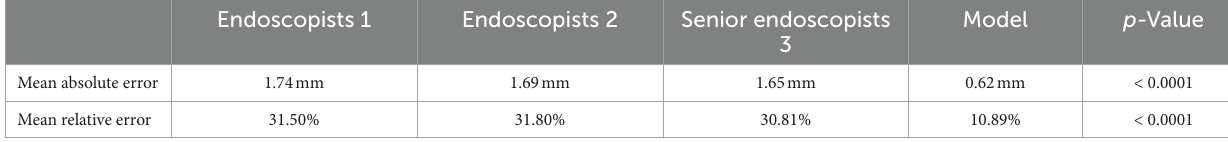
TABLE 5 Comparison of the difference of polyp size measurement competence in colorectal polyp size measurement model with endoscopists. Endoscopists 1 Endoscopists 2 Senior endoscopists 3